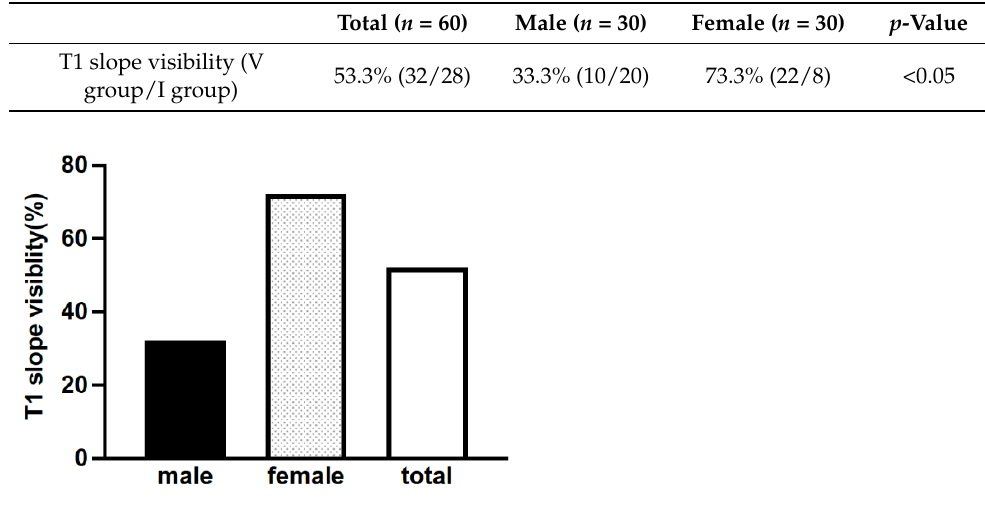
Figure 1. T1 slope visibility.